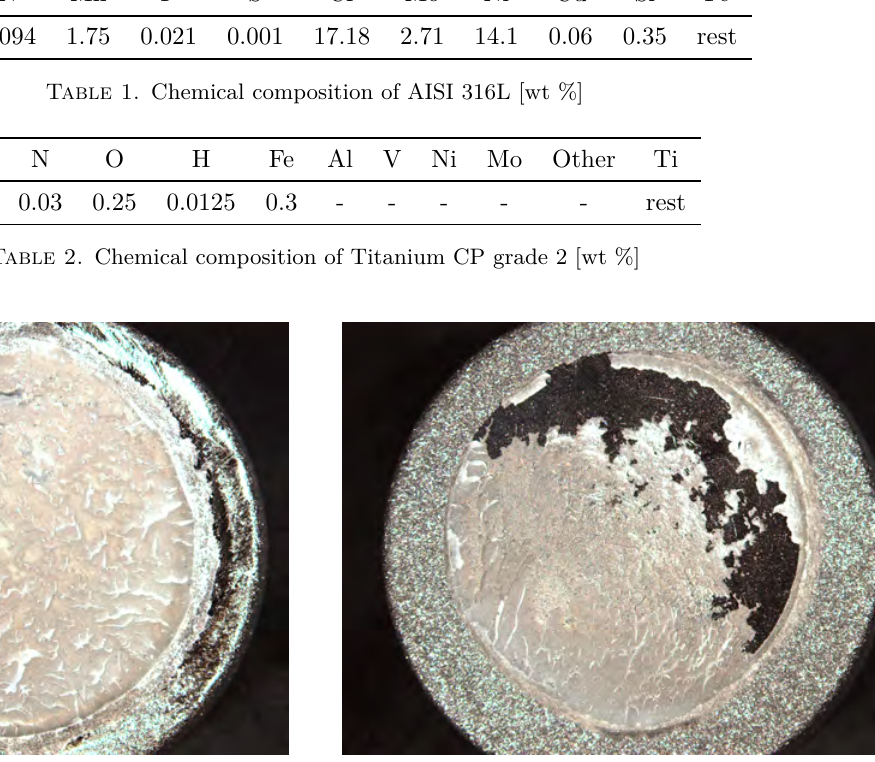
Figure 3. Titanium alloys